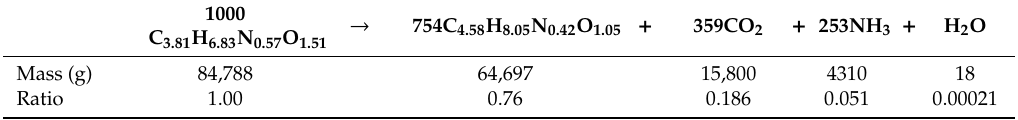
Table A6. Microalgae biomass stoichiometry at HTL process